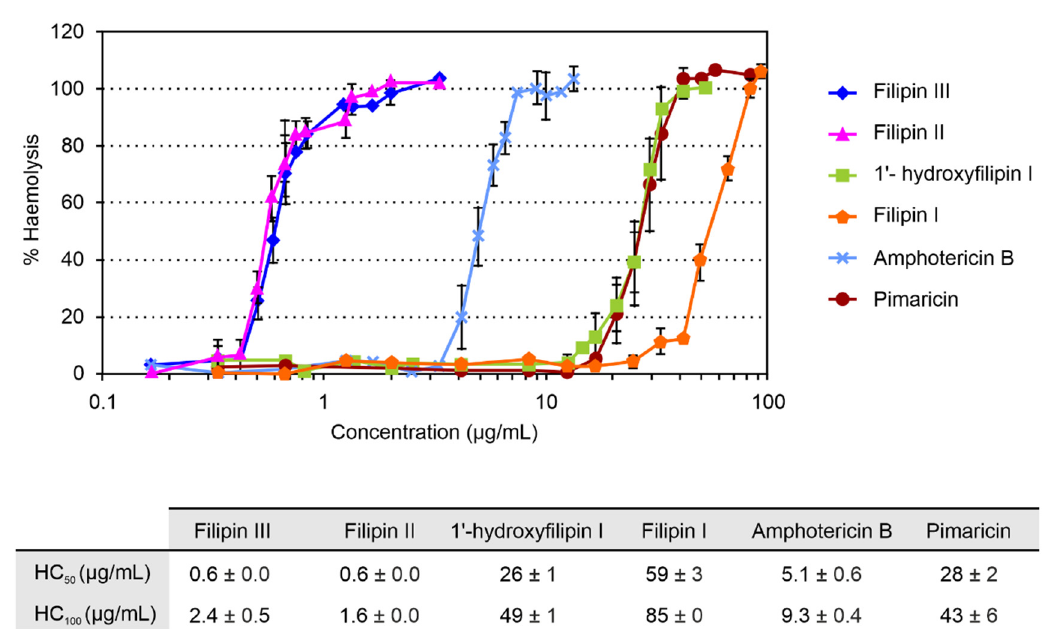
Figure 3. Haemolytic activity of filipin III and its intermediates. Haemolytic activity of pimaricin and amphotericin B was determined under identical conditions for comparison. Haemolytic activity caused by pure water was considered as 100%. Data are the average of three determinations from independent experiments. Vertical bars indicate the standard deviation